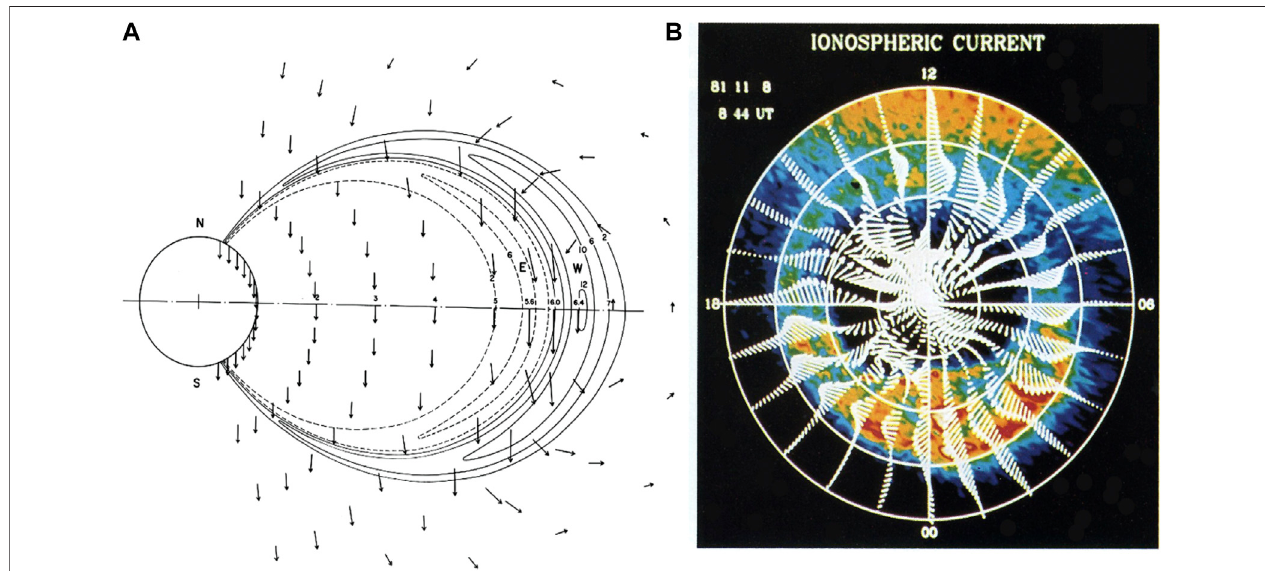
FIGURE 9 | (A) The distribution of the ring current and the magnetic fi eld produced by the current; note that the current fl ows westward half of the belt, and eastwardintheinnerhalfAkasofuetal.,1961). (B) Thesimultaneousobservationoftheionosphericcurrent(basedonground-baseddata)andthedistributionofauroras (satellite observation); Craven et al.